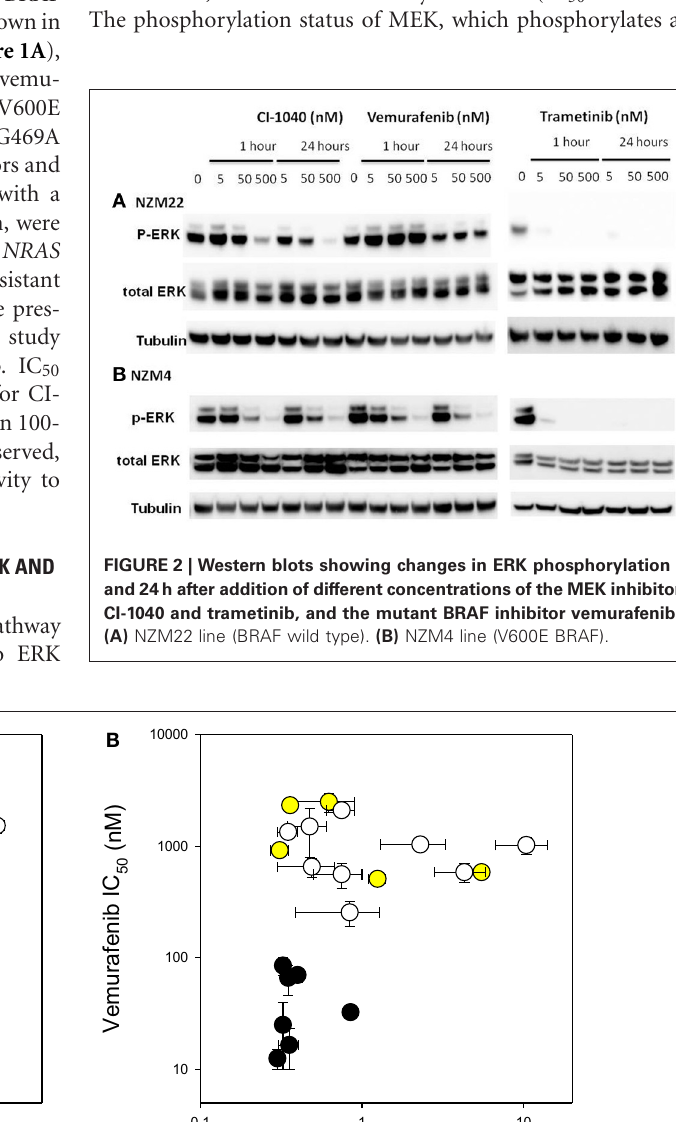
Trametinib IC (nM) 50 wildtype for BRAF and NRAS. Vertical and horizontal bars indicate the standard errors of the means where available; IC 50 values of < 7.8nM are shown as